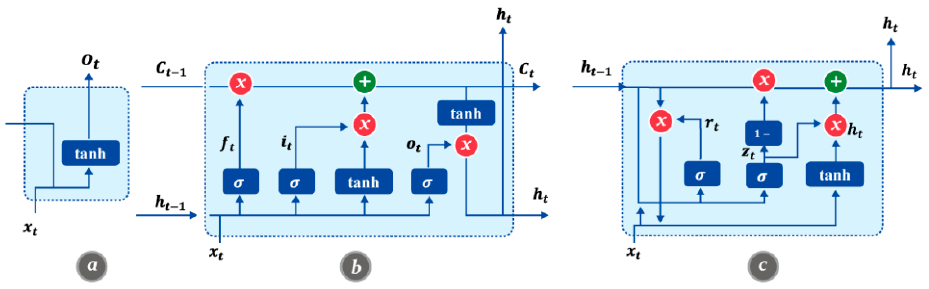
Figure 3. Structure of recurrent neural networks and different cell units: ( a ) RNN, ( b ) LSTM, and ( c ) GRU.